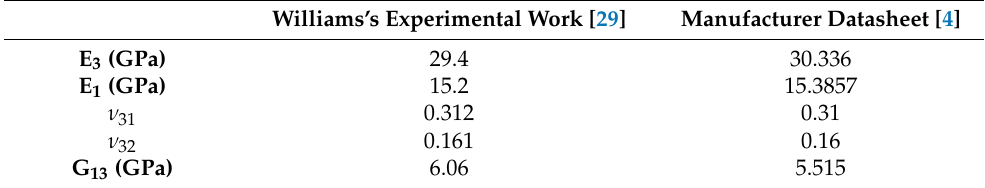
Table 1. Comparison between Williams’s experimental measurements and manufacturer